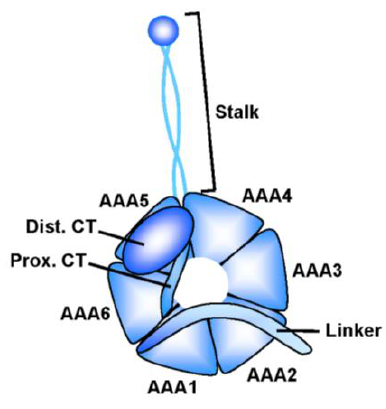
FIGURE 2. Depiction of the dynein head and its mechanical components based on high- resolution electron microscopy